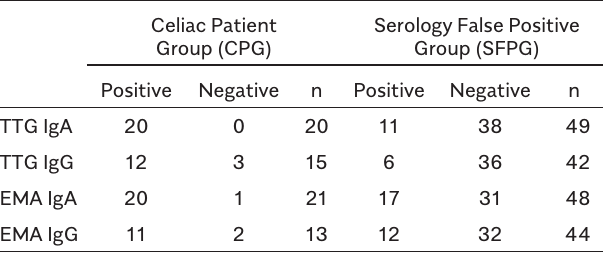
Table 2. The Distribution Characteristics of Positivity and Negativity of the Celiac Antibodies in Two Patient Groups With Positive Celiac